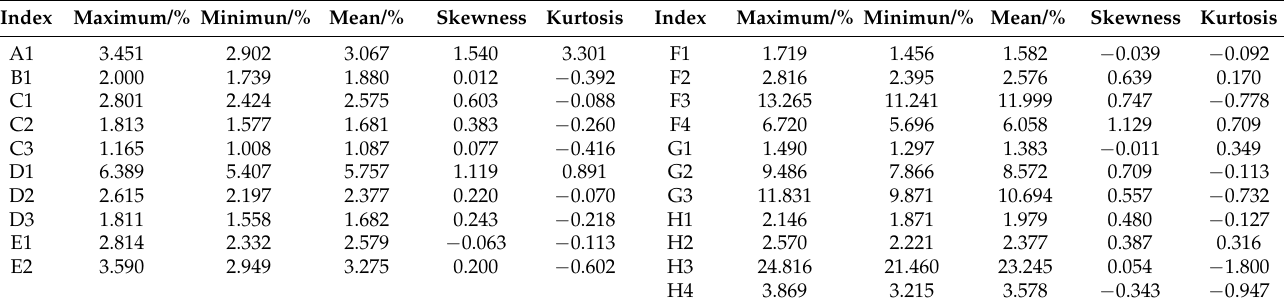
Table 4. Statistical characters of obstacle amounts against the performance of